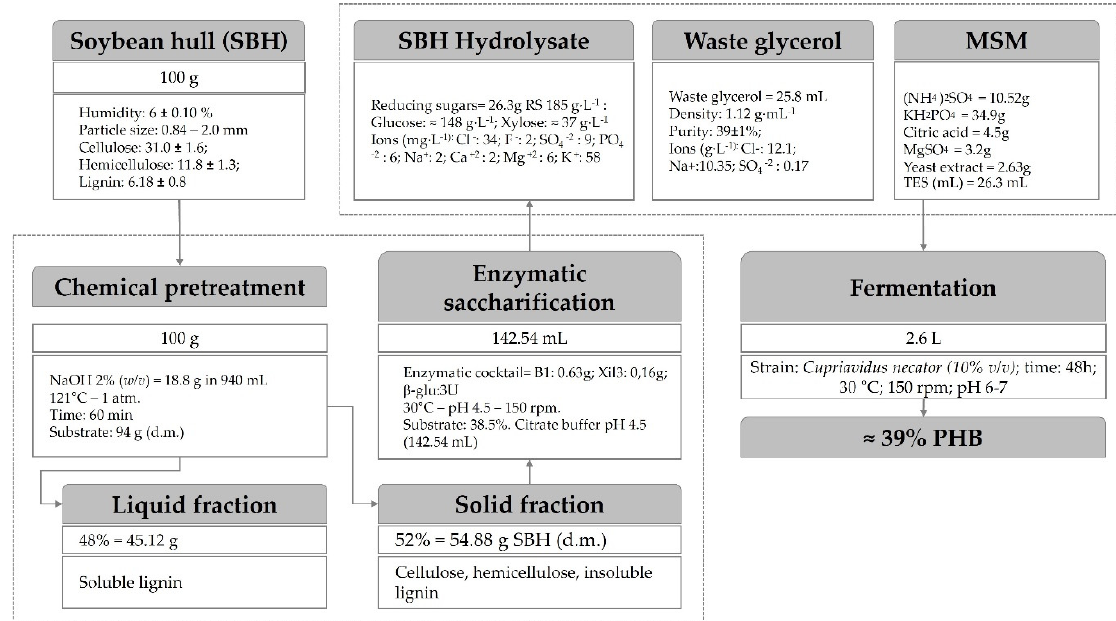
Figure 3. Mass balance of the production process of PHB by C. necator DSMz 545 in MSM medium containing SBHH and WG as carbon sources. containing SBHH and WG as carbon